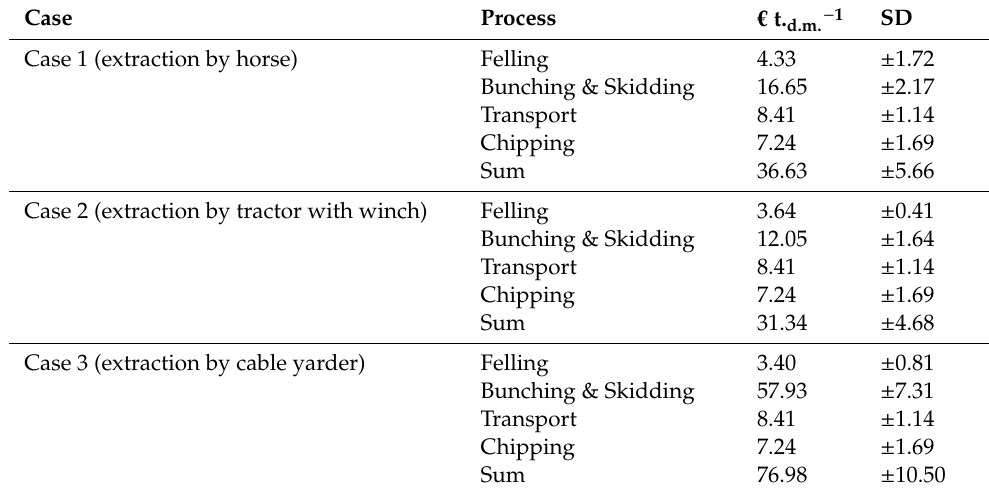
Table 5. Resulting production € s per process and case, in € per ton d.m